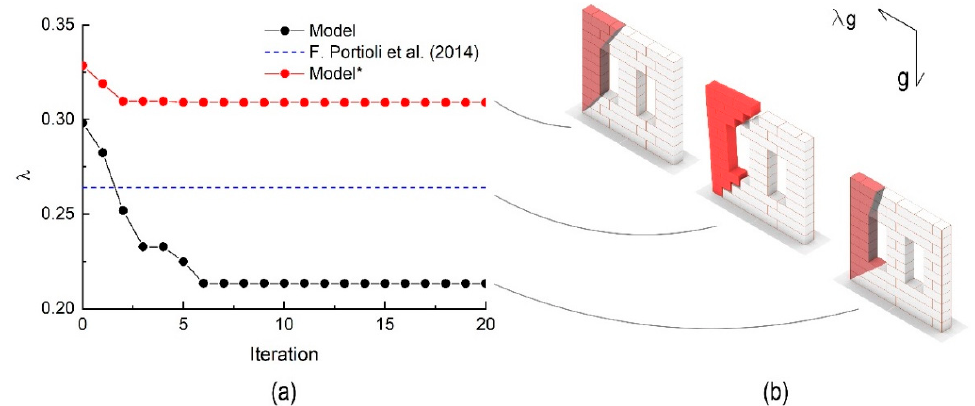
Figure 8. ( a ) Load multiplier vs. Iterations and comparison with the values arising from the reference micro-block model [39] and alternative limit analysis formulation of Reference [31]. ( b ) Geometry representation of the failure mechanism at the last iteration.